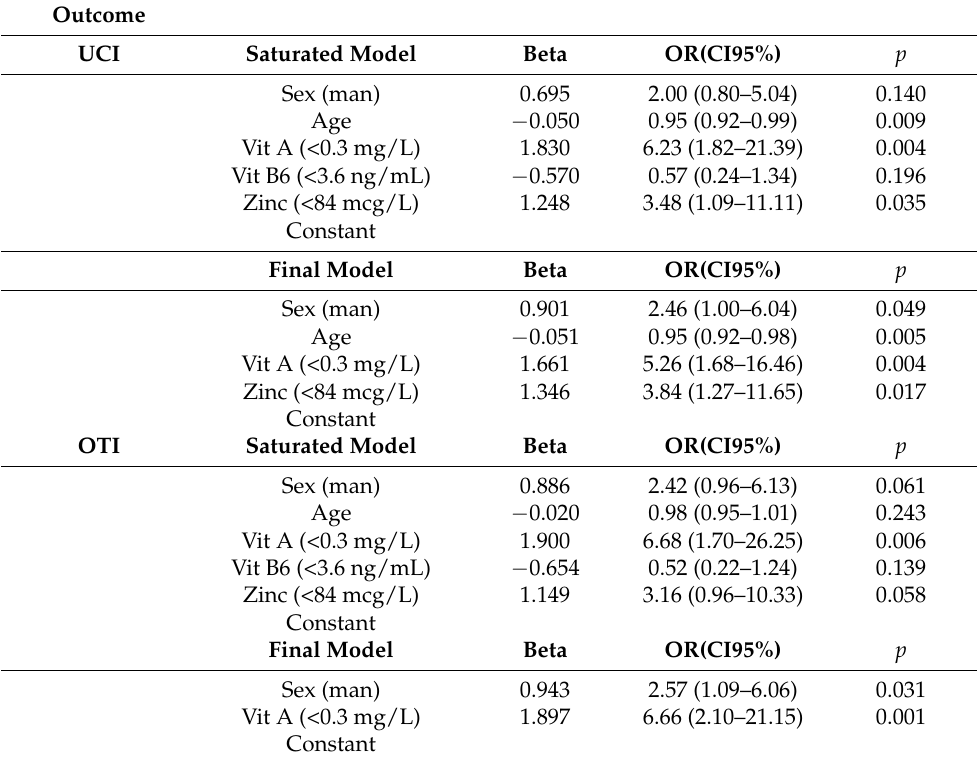
Table 5. Summary of the multivariate logistic regression analysis with its initial saturated models and resulting final models, regarding the outcome (ICU and